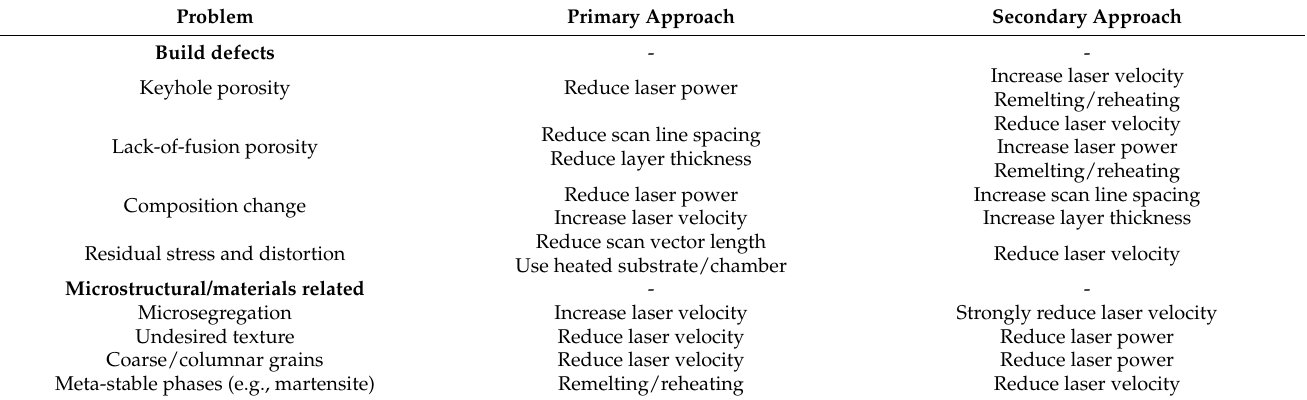
Table 9. Measures to combat build and microstructural problems in L-PBF. Based on